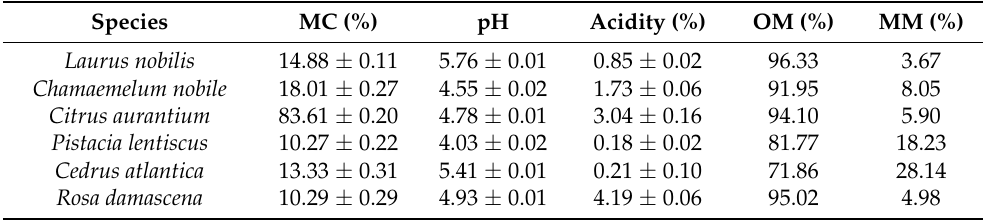
Table 1. Quality control of plant matter: moisture content (MC), pH, acidity, organic material (OM), and mineral matter